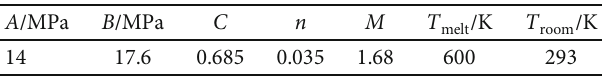
Table 7: Parameters of the Johnson-Cook model for the lead casing